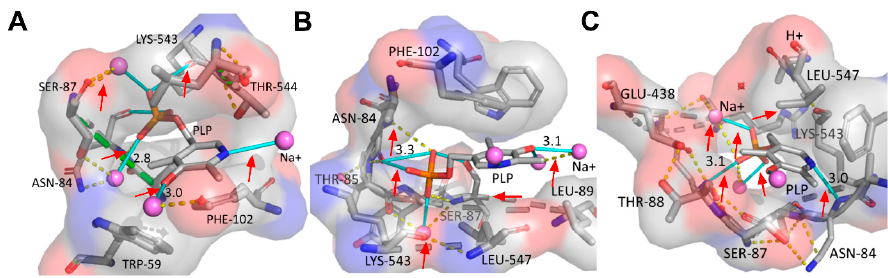
Figure 4. Mutation-induced structural alterations of WT and mutants. ( A – C ). This showed the various PLP conformations and interactions between protein residues, cofactor PLP and metal ions for the WT, Ser512Ala and Arg595Lys mutants, at optimum whole-biotransformation temperature of 40 ◦ C. The hydrogen bonds are represented by cyan sticks, the dotted lines (yellow) are polar contacts, while van der Waals interactions are indicated by the green dotted